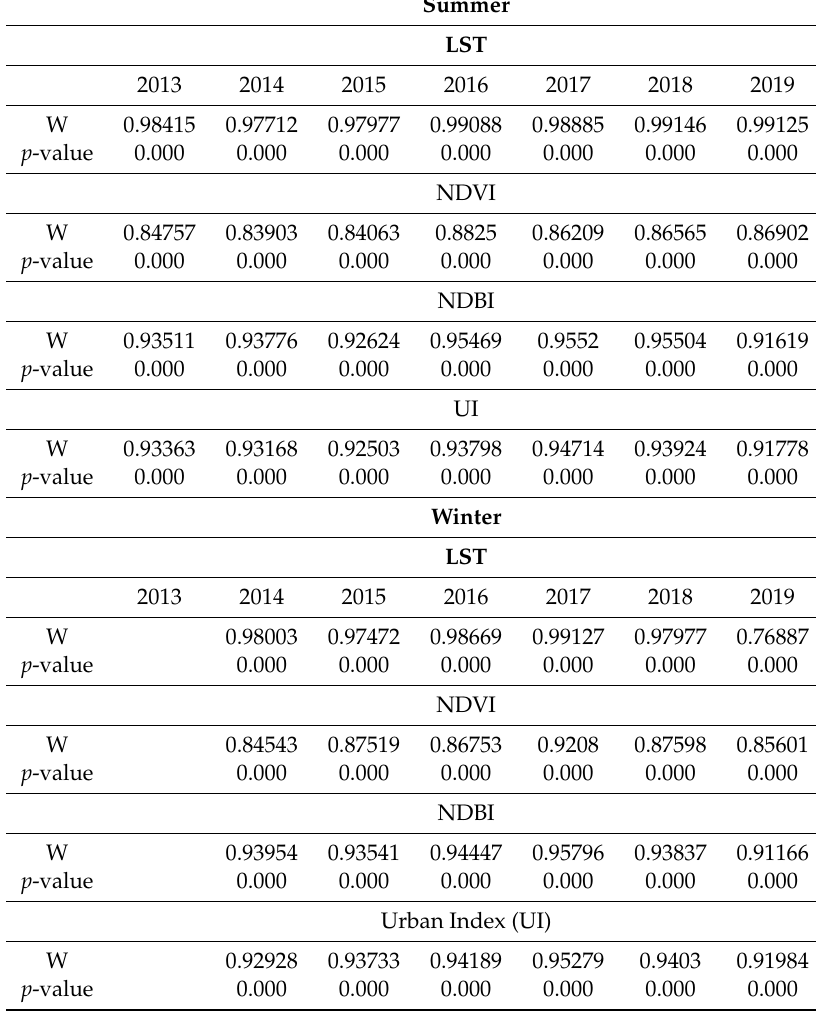
Table 1. Shapiro–Wilk test for normality. Examination of the distribution of LST, NDVI, NDBI, and UI during the summer and winter